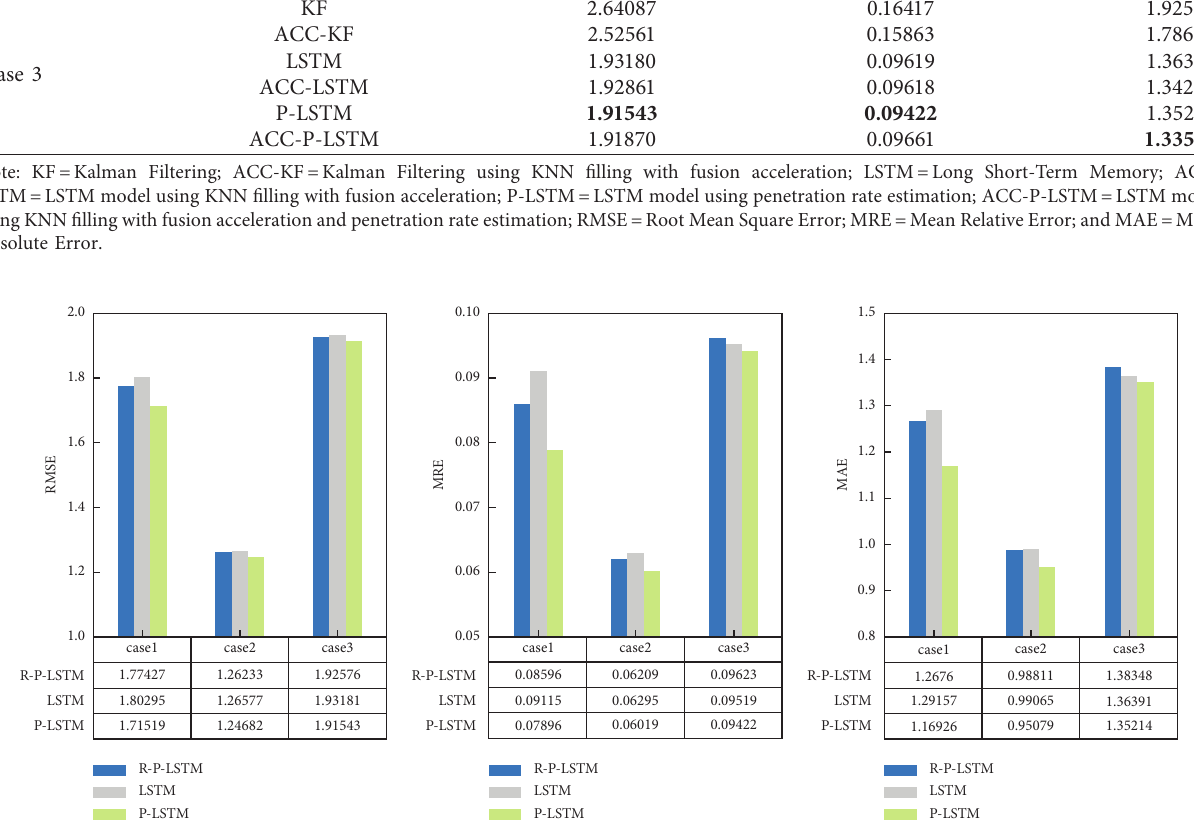
Figure 6: Error bar graph of error of R-P-LSTM, LSTM, and P-LSTM in three cases. Note: LSTM � Long Short-Term Memory; P- LSTM � LSTM model using penetration rate estimation; and R-P-LSTM � LSTM model using random penetration rate; RMSE � Root Mean Square Error; MRE � Mean Relative Error; and MAE � Mean Absolute